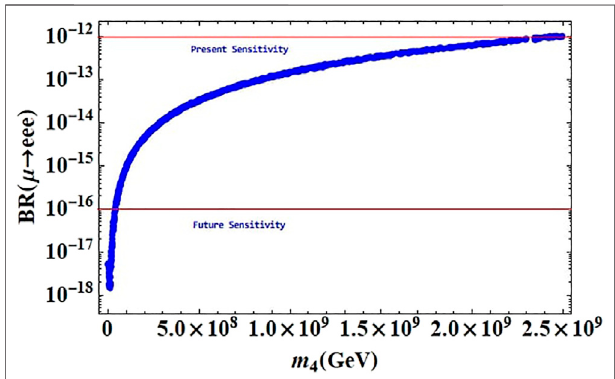
FIGURE 7 | BR ( μ − eee ) as a function of the sterile neutrino mass. The red horizontal line represents the experimental bounds on this process.